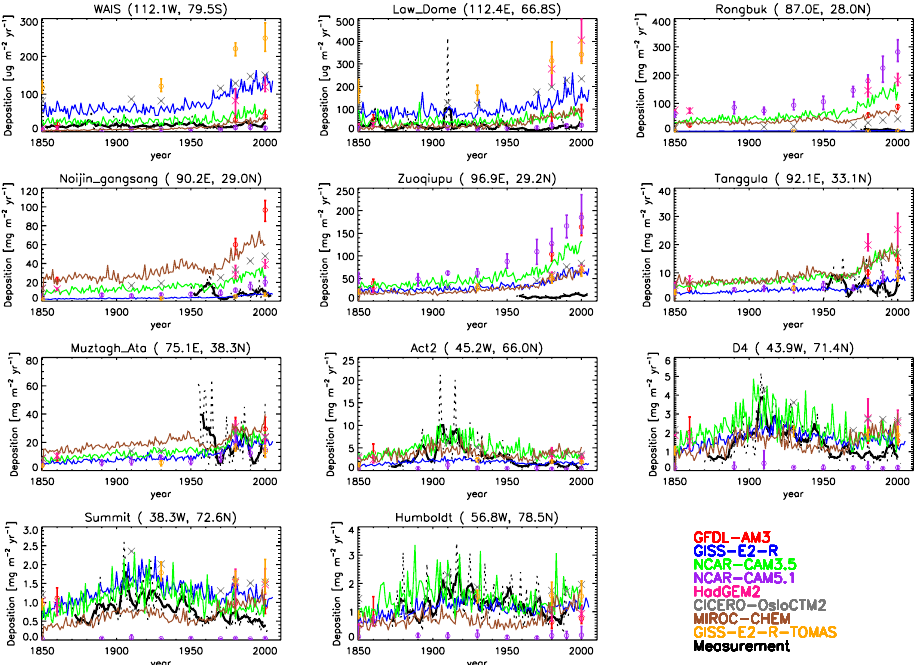
Fig. 11. Comparison of annual-average BC deposition fluxes in models to ice core observations. Observations are shown in two ways: annual-average shown in black dot and 5-yr running average shown in thick black line. Note that the CMIP5 transient simulations for NCAR-CAM3.5 and MIROC-CHEM are used here (presented as a solid line), instead of their ACCMIP timeslice simulations. For models with the timeslice runs, an error bar is used to present the mean of each timeslice run with its minimum and maximum of the corresponding timeslice runs and are positioned at the beginning of the corresponding timeslice year. CICERO-OsloCTM2 and HadGEM2 is presented with an “X” symbol for their